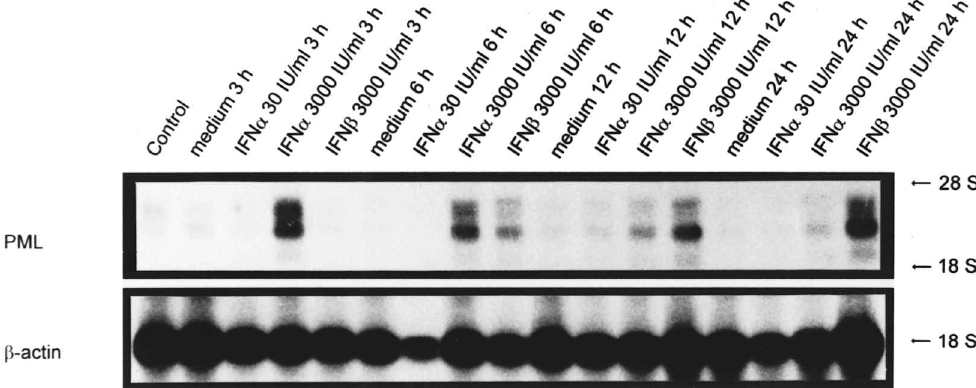
FIG. 2. Time-response of induction of PML mRNA by IFN- a and IFN- b . Northern blot analysis of PML-specific mRNA levels from IFN-treated and untreated PBMNC. PBMNC were treated with the indicated dose of IFN- a and IFN- b for the indicated time. Medium-treated PBMNC and freshly isolated PBMNC without further incubation were included as controls. Size fractionated total cellular RNA (20 m g per lane) was blotted and hybridized to the indicated 32 P-labelled cDNA probes.